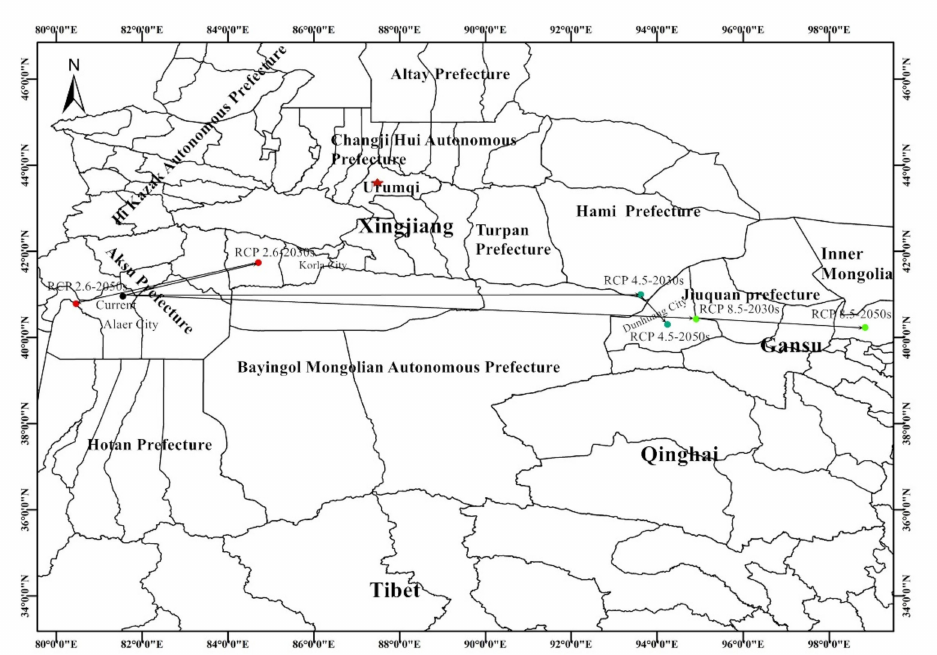
Figure 7. The core distributional shifts of T. klimeschi (Black dot represents current centroid; Red dot represents RCP 2.6 centroid; Bottle-green dot represents RCP 4.5 centroid; Bright-green dot represents RCP 4.5